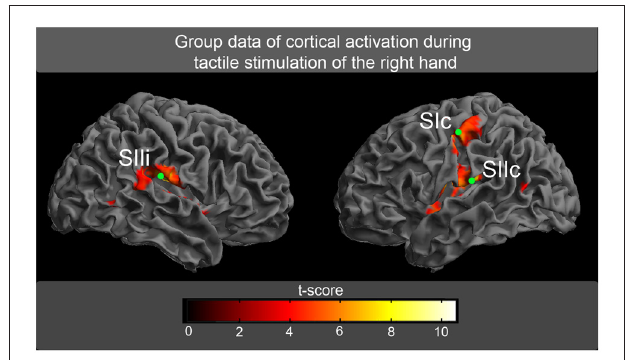
FIGURE 4 | The random-effect group analysis ( n = 17) of BOLD responses. Activations ( P < 0.01, false discovery rate [FDR]-corrected) in response to tactile stimulation of fingers 1 + 3 of the right hand are shown superimposed on an inflated brain. The green circles correspond to the spatial locations of the maximum activation, which was further used for the magnetoencephalographic (MEG) analysis (SI, primary somatosensory cortex; SII, secondary somatosensory cortex, c, contralateral to tactile stimulation; i, ipsilateral to tactile stimulation).